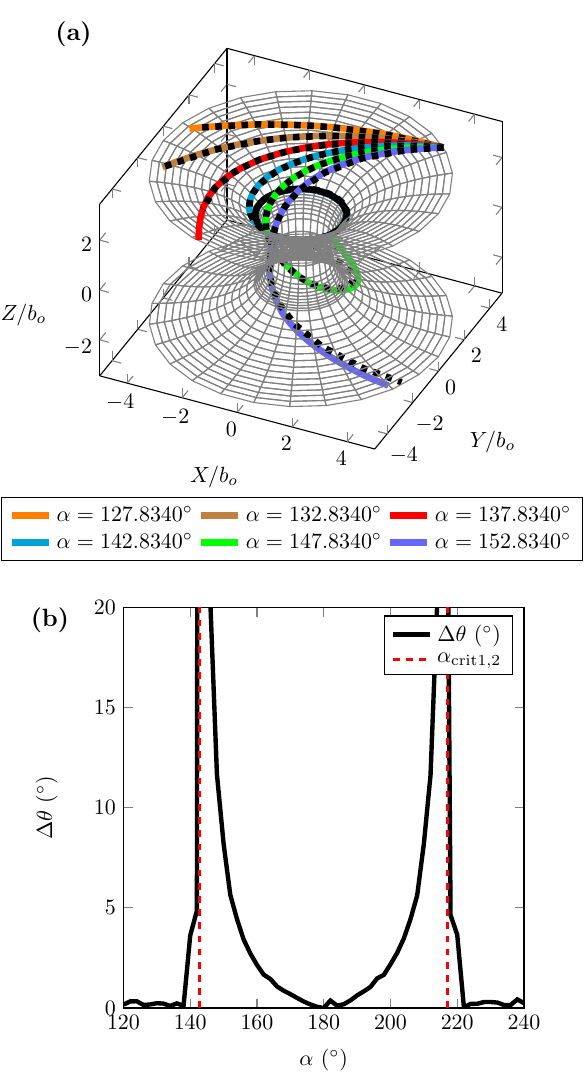
Fig. 6 Simulation results for WH framed in the metric theory of grav- ity: ( b 0 ,γ) = ( 0 . 5 , 1 . 5 ) , R i = 5 r s , φ i = 45 ◦ , and (cid:14)μ max = 10 − 2 b 0 . Panel a : Geodesics generated for different emission angles α . Solid color are results obtained with the proposed algorithm and black dashed lines are results obtained from the orbital equation. Panel b : Angular deviation versus emission angle α inside the range: 120 ◦ − 240 ◦